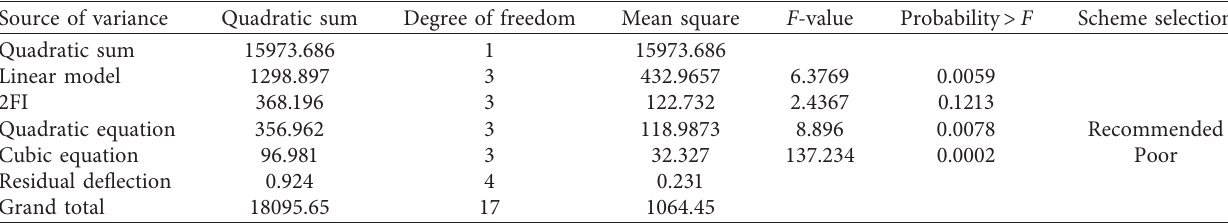
Table 10: The variance of combustibility index using different models.